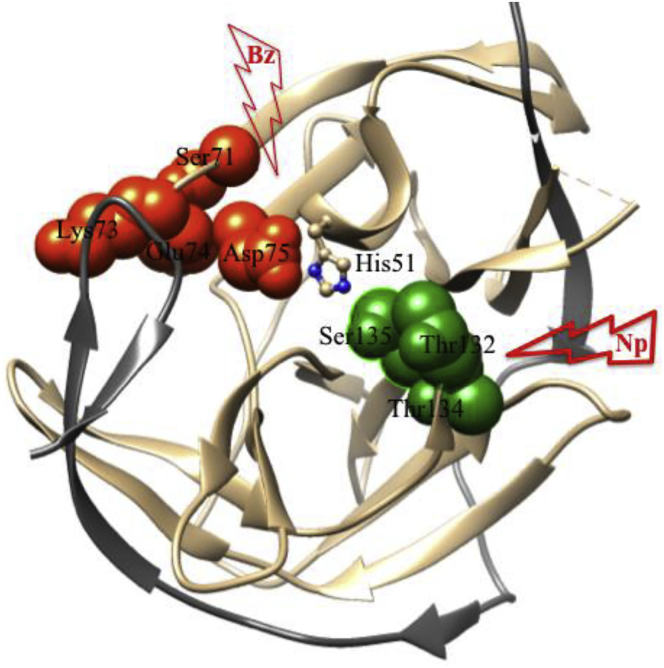
Peptide-Based Inhibitor of Viral ProteaseCrystal structure showing oxidative damage to West Nile Virus NS2B/NS3 (PDB: 2FP7). Amino acid residues, green set (Ser135, Thr132 and Thr134) and orange set (Asp75, Ser71, Lys73 and Glu74) are modified by naphthoylated (Np) and benzoylated metallo-peptide (Bz) respectively. His51-Asp75-Ser135 triad is active site. Modified from Pinkham et al. (2018a).